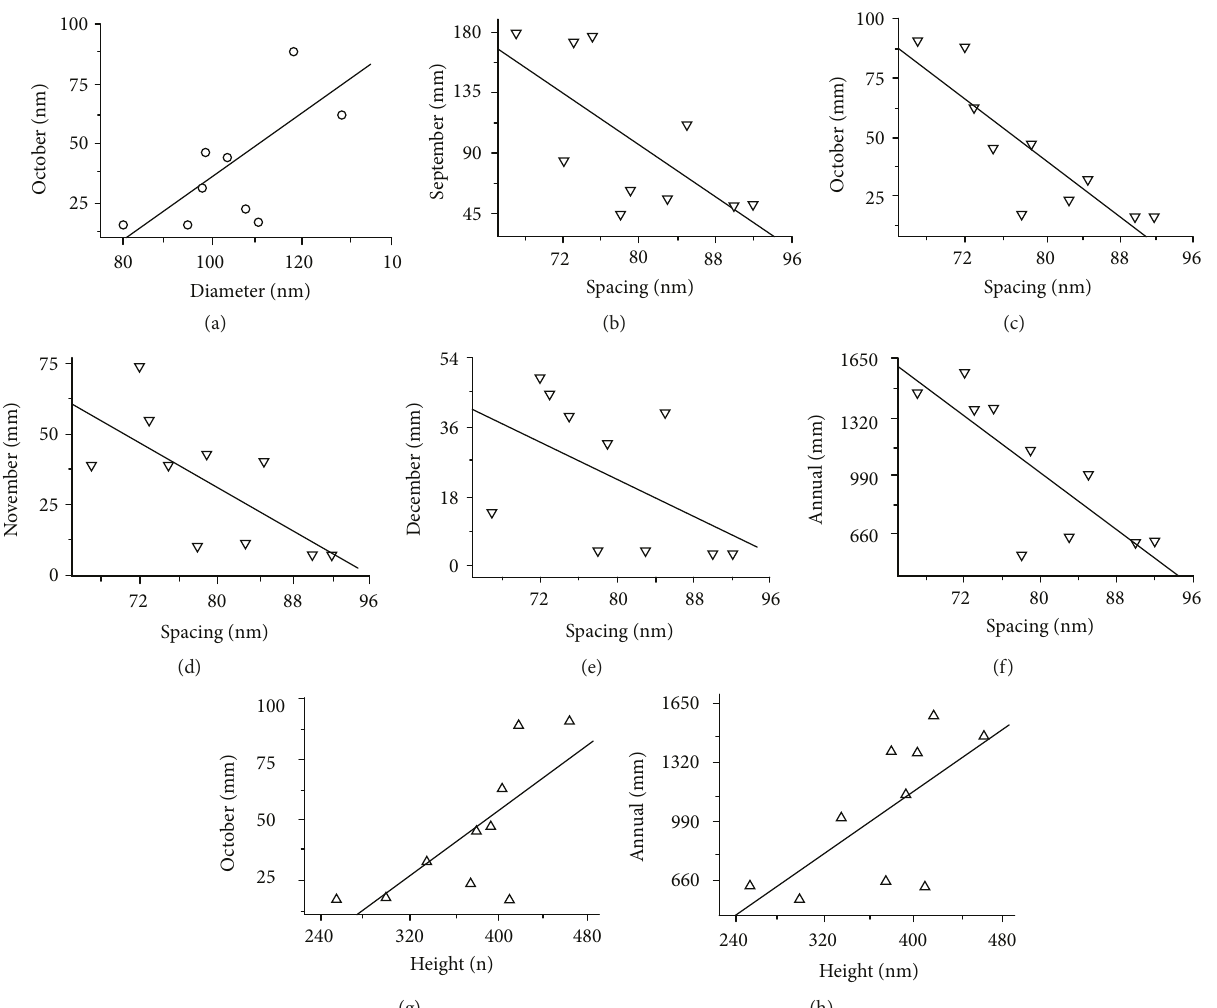
Figure 4: Correlation of the nanostructure with the month and annual average precipitation rates between the years 1950 and 2000, at the various locations the cicada Cryptotympana atrata was distributed. (a) The diameter of protrusions shows a positive correlation with the precipitation in October. (b – f) The spacing of protrusions displays a negative relationship with September to December and annual precipitation. (g, h) The height of protrusions shows a positive correlation with the precipitation of October and annual rainfall, respectively. The data were obtained from the WorldClim